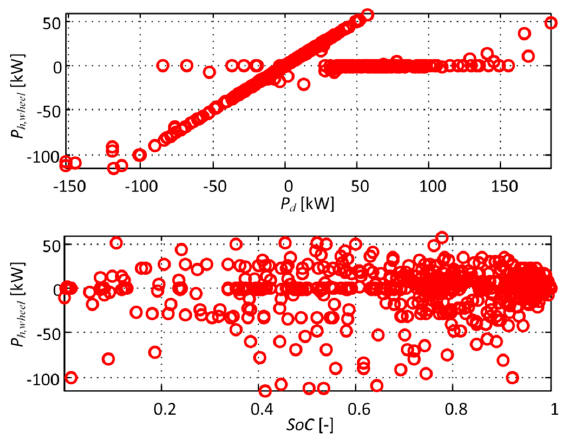
Figure 9. Dependence of the optimum power of the hydraulic motor supplied to the wheels P h,wheel on the required power P d and SoC for each driving cycle.